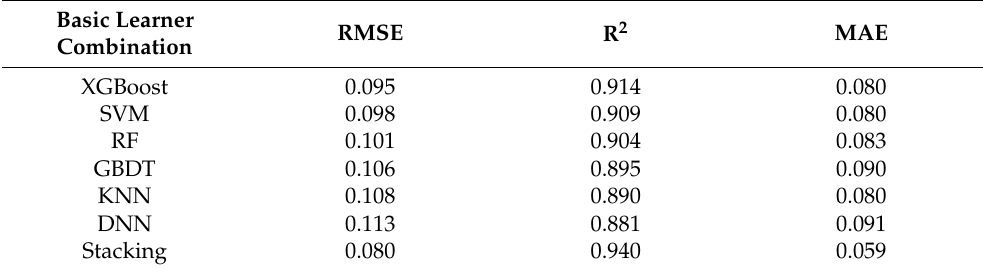
Table 6. Prediction error stacking for various base learner combinations.